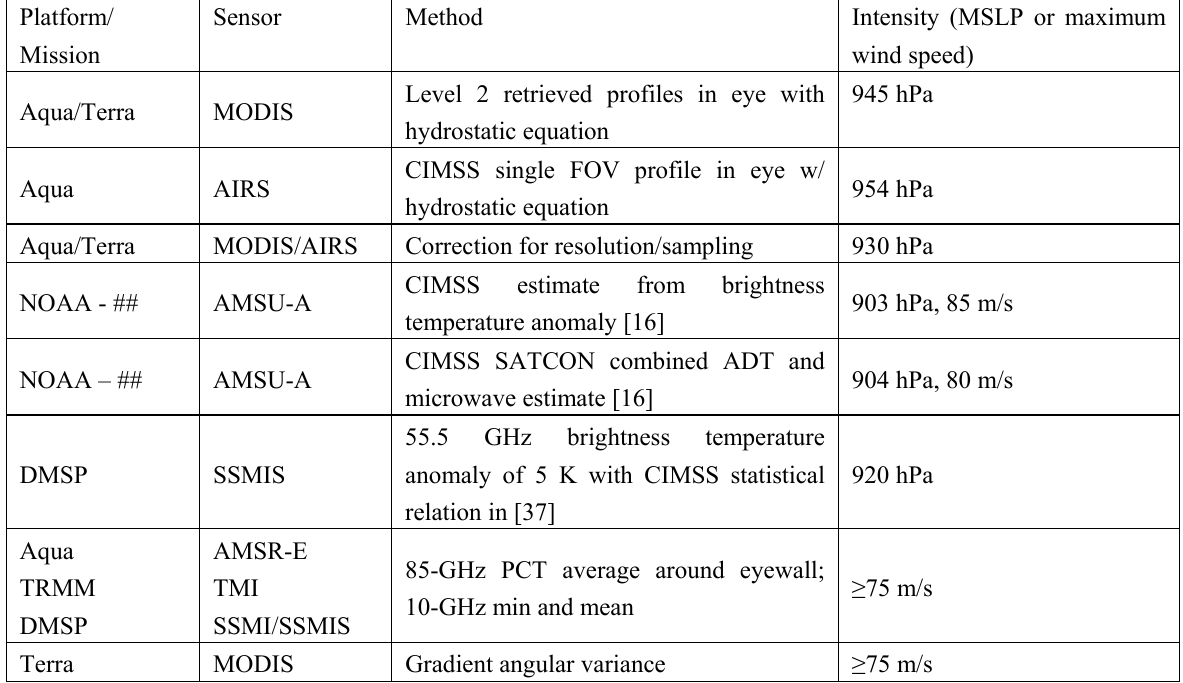
Table 5. Cyclone Monica satellite intensity (non-Dvorak) estimates.